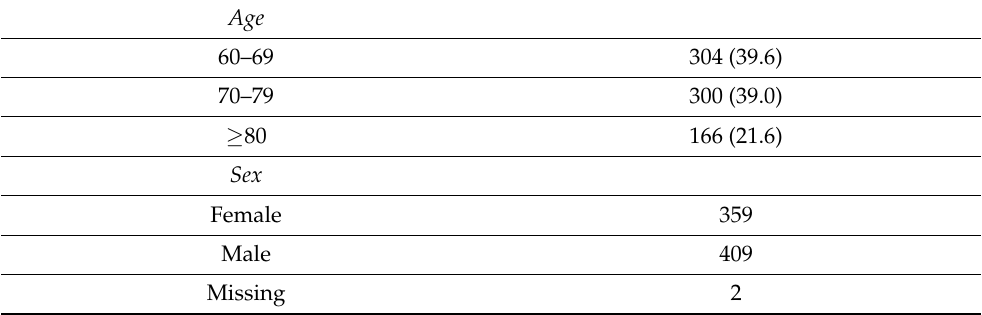
Table 2. Background characteristics of patients at baseline ( N =